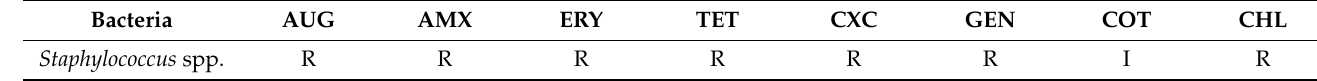
Table 2. Antibiotic susceptibility patterns for the raw chicken meat associated bacteria. Bacteria AUG AMX ERY TET CXC GEN COT CHL Staphylococcus